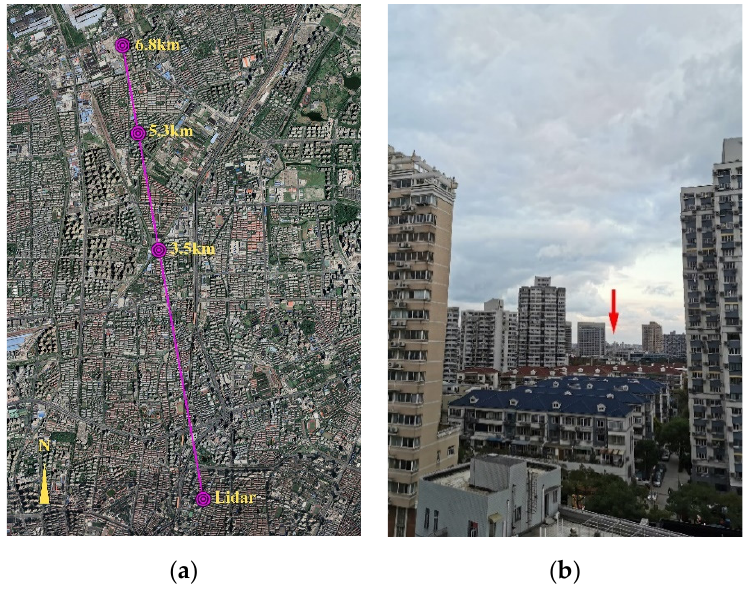
Figure 5. ( a ) The bird view of the lidar transmit–receive path in hard target ranging test, the pink line and circles denoted the path and the detected buildings, respectively. ( b ) The view along the lidar pointing direction from the laboratory, the red arrow indicated the farthest target of the ranging test.